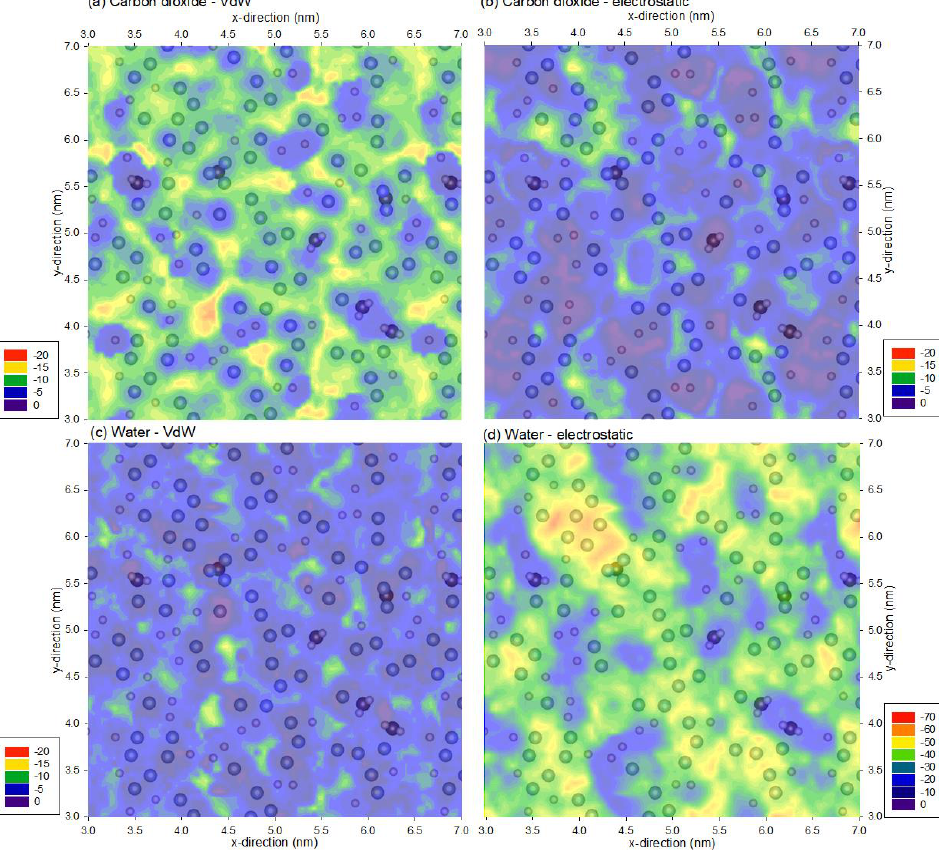
Figure 3. Minimum van der Waals and electrostatic interaction energy of ( a , b ) a carbon dioxide and ( c , d ) water molecule and the PVDF membrane. Note that the profiles are superimposed with PVDF atoms from the top 0.1 nm of the membrane, and the range for the legends are different; the legends are represented in kJ/mol.